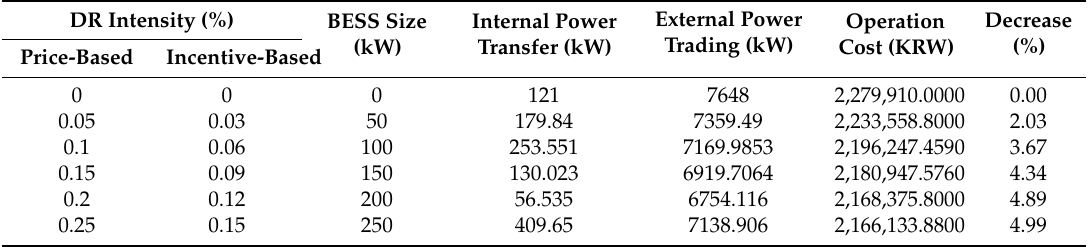
Table 7. Effect of DR intensity & BESS size on power transfer and operation